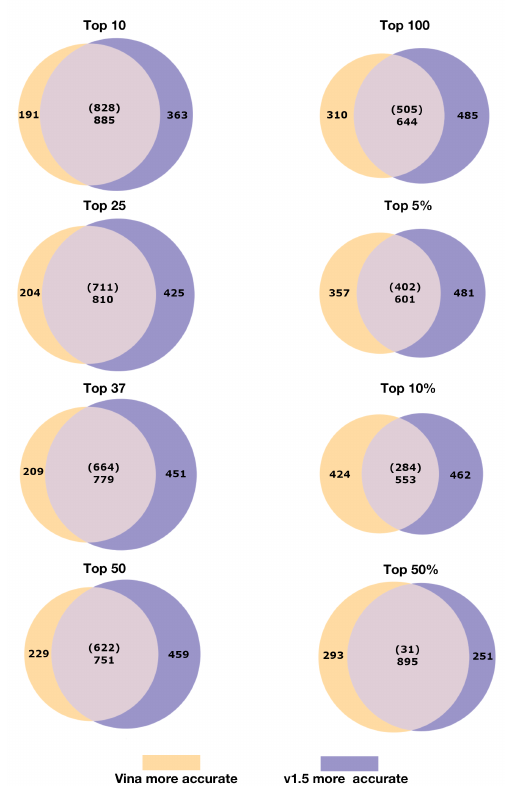
Figure 3. Comparing and contrasting indication accuracies for two CANDO platform pipelines at different cutoffs. Each Venn diagram represents the set of indication accuracies (1439 total) for the Vina-134 and v1.5-134 pipelines at different cutoffs (top10, top25, top37, top50, top100, top5%, top10%, and top50%). Indications that scored higher for the Vina pipeline are in yellow. Indications that scored higher for the v1.5 pipeline are in purple. Indications that scored the same for each pipeline are in gray. The number of indications where both pipelines yield 0% accuracy are provided in parentheses and the total number of equal indication accuracies provided below. At the top10 cutoff, the Vina-134 pipeline yields higher accuracies for 191 indications and the v1.5 pipeline for 363 indications, and each pipeline yields the same accuracy for 885 indications. Although the Vina-134 pipeline produces a substantial number of indication accuracies that are higher or equivalent to v1.5 indication accuracies, the v1.5 pipeline outperforms the Vina-134 pipeline at every cutoff except for top50%. Nonetheless, the orthogonality in the above diagrams indicates that individual pipelines can be synergistically combined into a hybrid pipeline that yields considerable performance